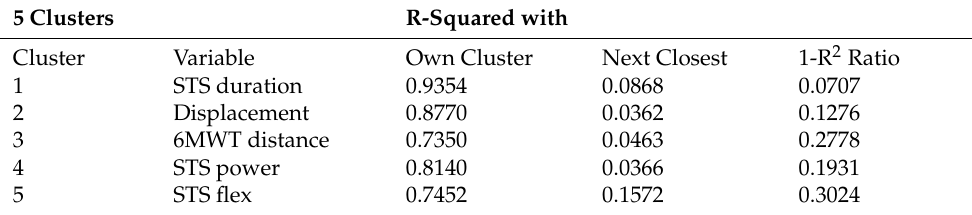
Table 3. Clustering characteristics for the physical capacity parameters selected.